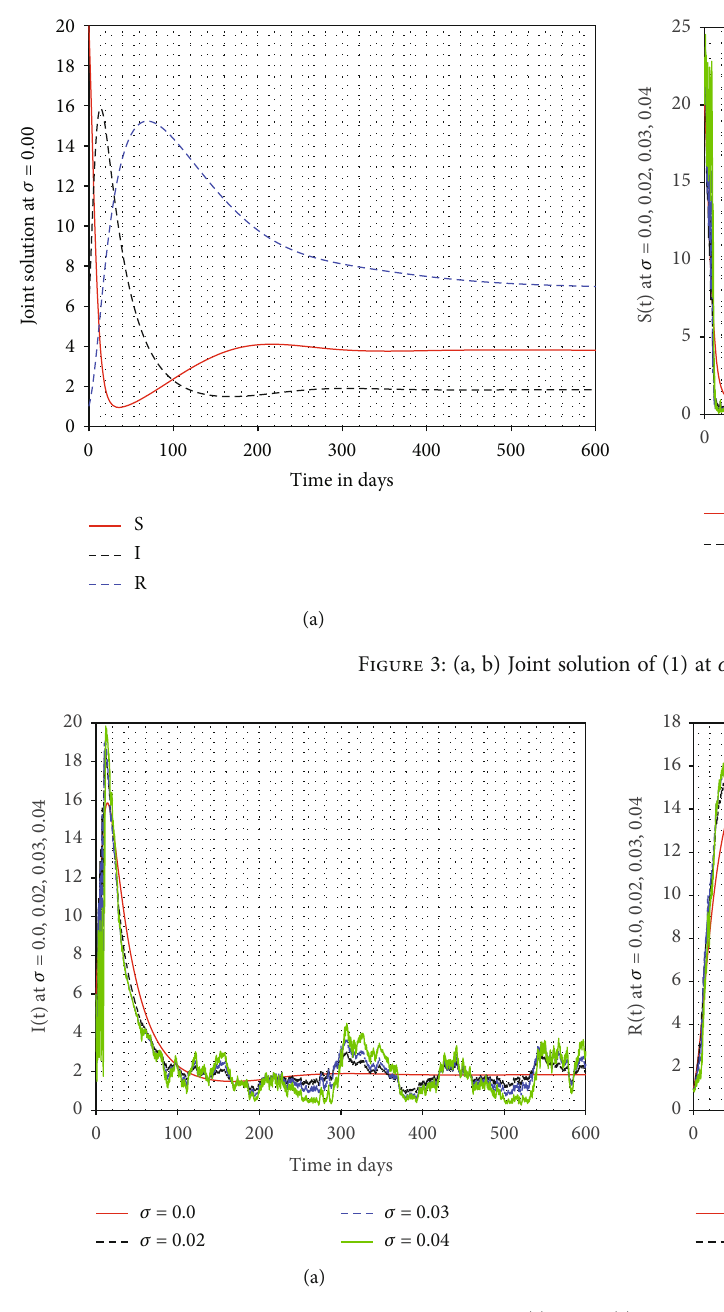
Figure 4: (a, b) I ð t Þ and R ð t Þ for di ff erent values of σ